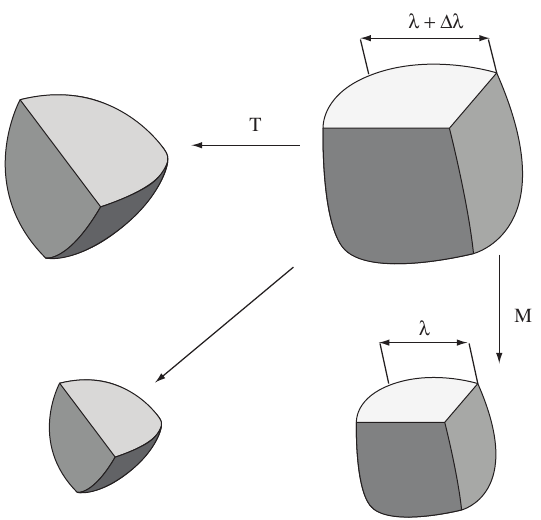
Figure 1. The 6-hedron with a vertex-to-vertex distance equal to λ + ∆λ , shown in the upper right can decrease its volume by losing faces to become the 4-hedron on the top left exhibiting the same vertex-to-vertex distance, λ + ∆λ . This is indicated by the arrow labeled ‘T’ for topological process. Another possibility is that the 6-hedron may decrease its volume by just decreasing its vertex-to-vertex distance from its original value, λ + ∆λ , to a smaller value, λ . In the metrical process the 6-hedron merely becomes a smaller 6-hedron as shown on lower right-hand side. This process is indicated by an arrow labeled ‘M’ for metrical process. Finally, 6-hedron might shrink by a combination of the two processes: losing faces and also decreasing its vertex-to-vertex distance. This combined process is indicated by the arrow labeled ‘T +